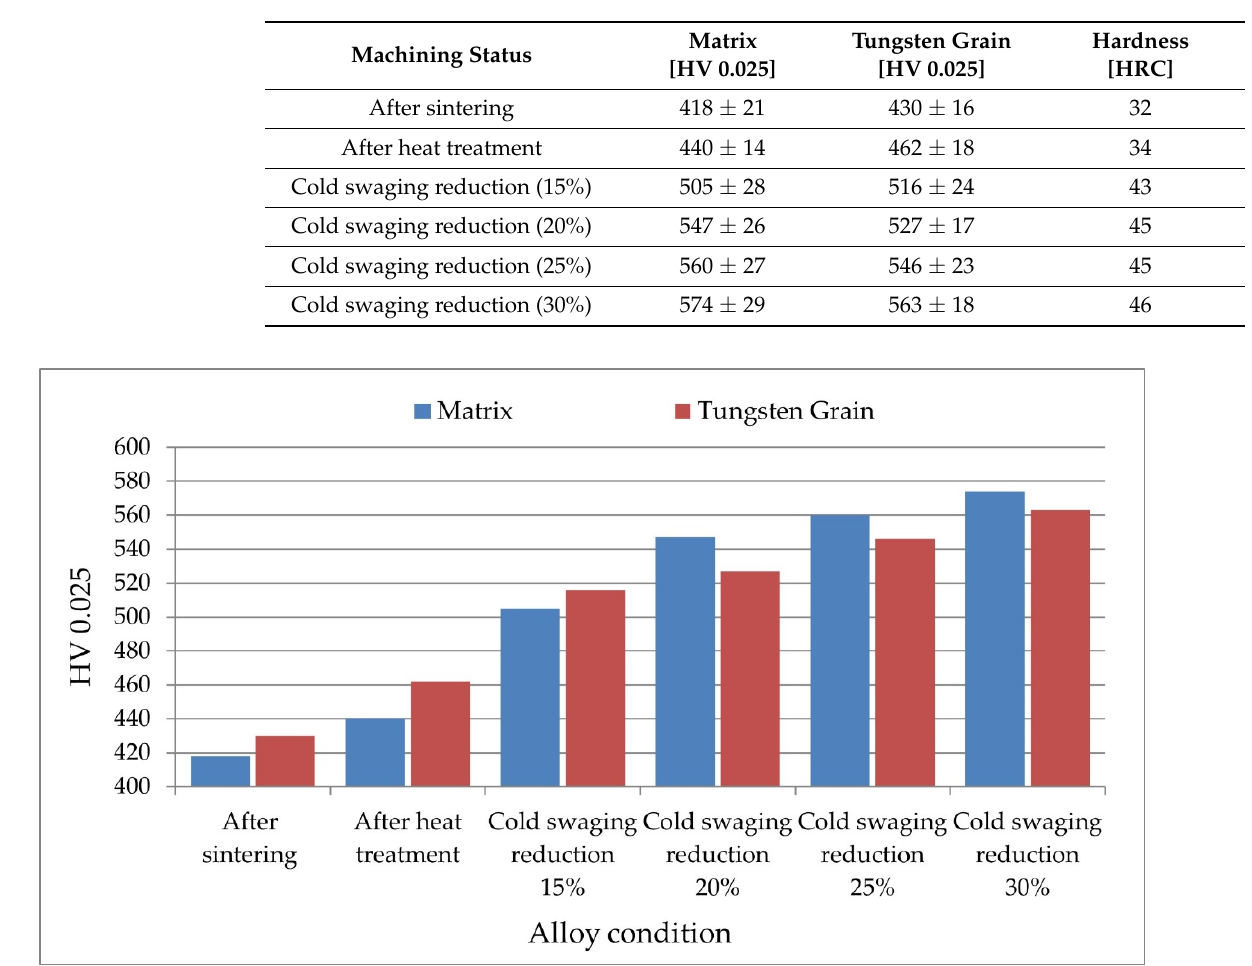
Figure 10. The results of microhardness HV0.025 of tungsten grains and matrix measured along the rod axis.